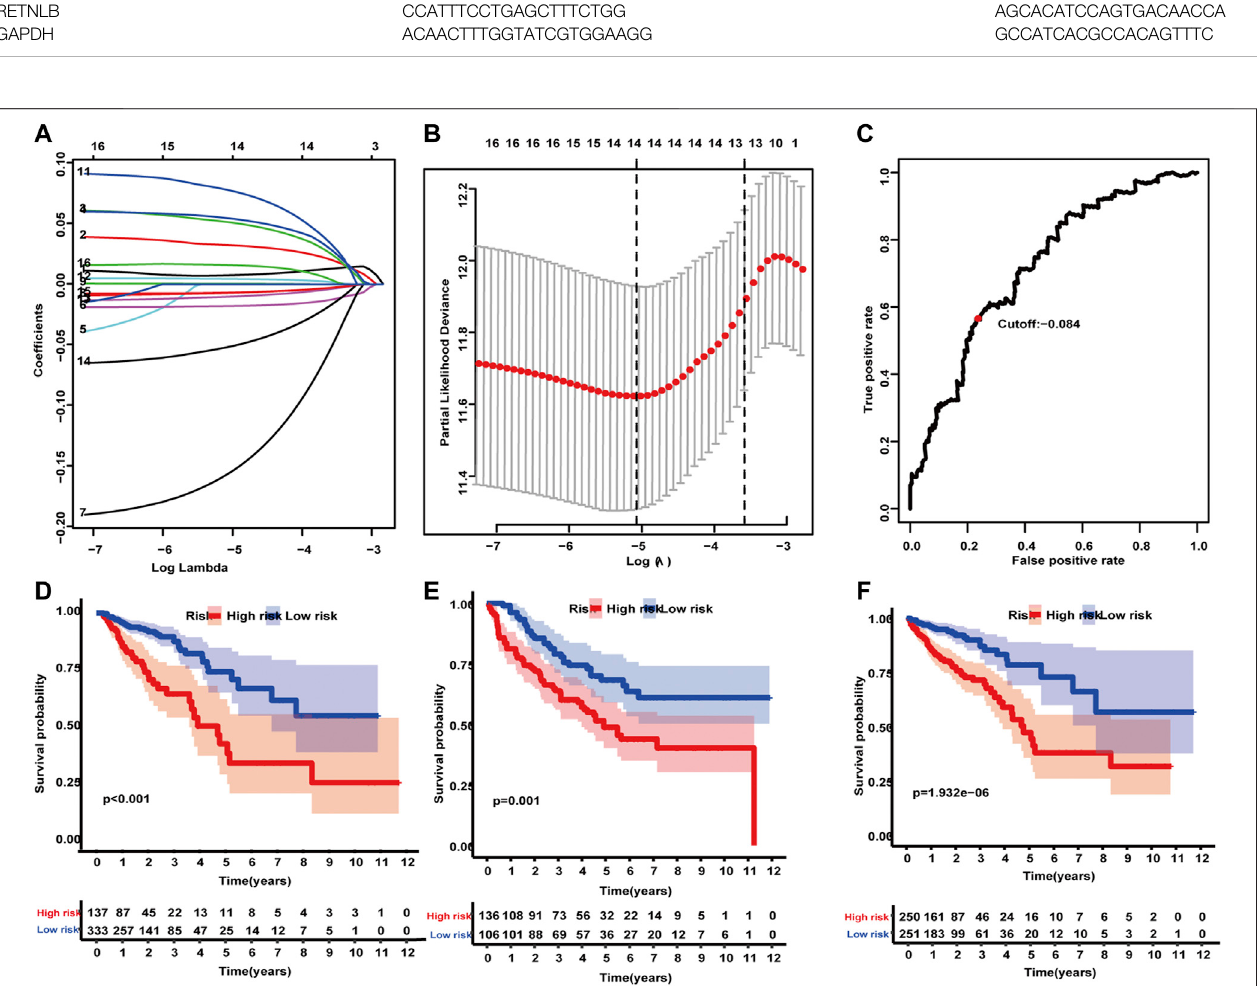
FIGURE2| ConstructionandvalidationofanIRGpredictivemodel. (A) Tenfoldcross-validationfortuningparameterselectionintheLASSOmodelusingminimum criteria. (B) LASSOcoef fi cientpro fi les ofthe17IRGs.Averticallinewasdrawn atthevalueselected using10-fold cross-validation, wherethe optimal lambda resulted in 14 nonzero coef fi cients. (C) The optimal cutoff value was determined. (D – F) The Kaplan – Meier method applying the two-sided log-rank test was performed to estimate differences in OS between high- and low-risk groups in the training, test, and validation cohorts.